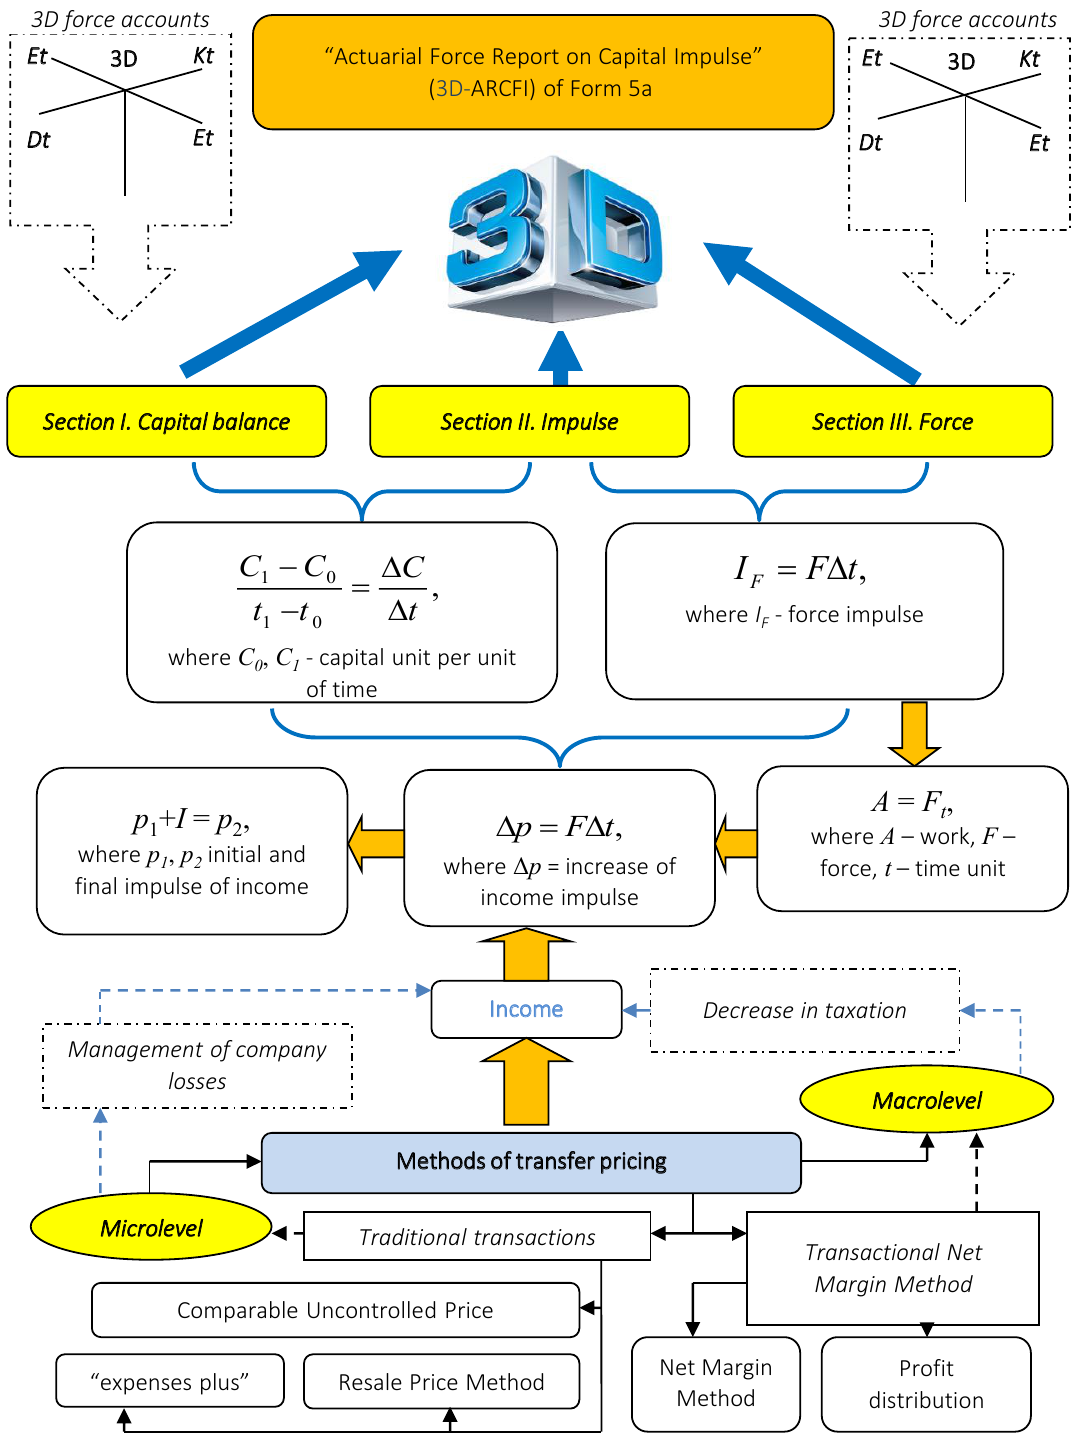
Figure 2. Profit force impulse management model: transfer approach